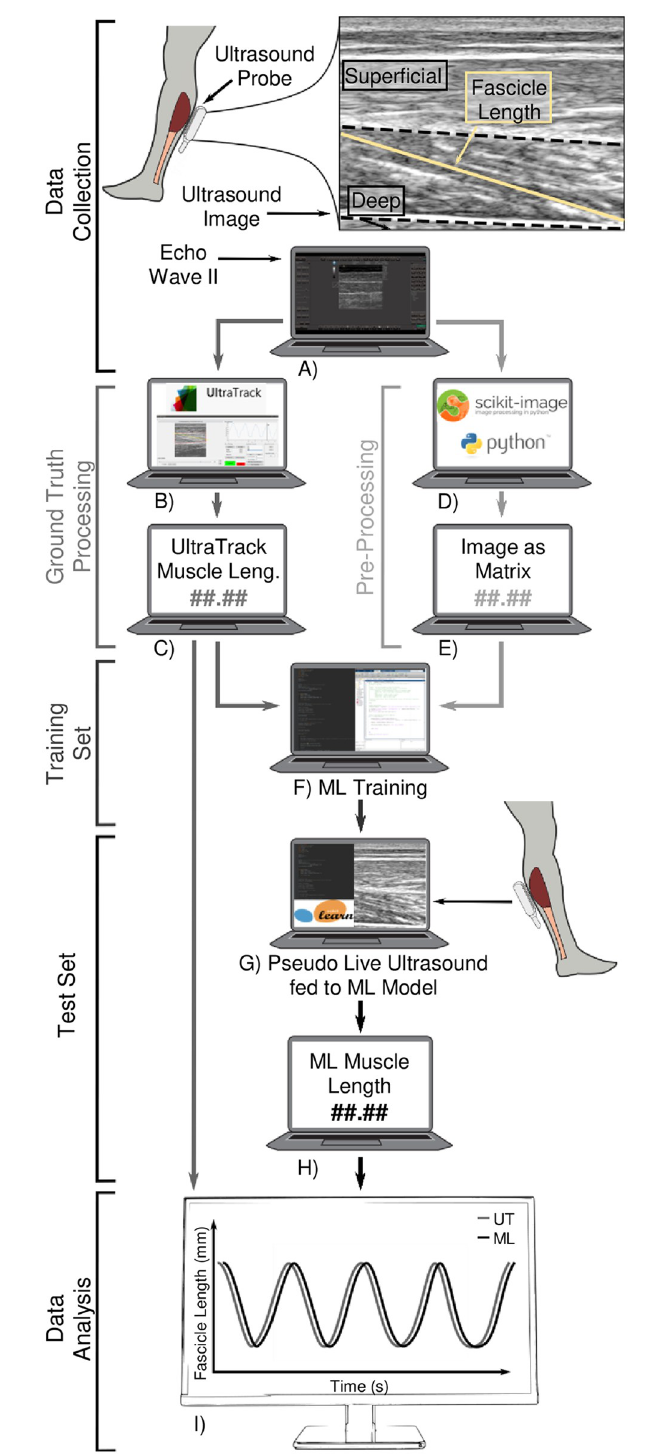
Fig 2. Workflow from B-mode ultrasound image acquisition and processing to machine-learning (ML) model training and real-time muscle length tracking. A) In each frame, a B-mode image containing human soleus muscle fascicle (yellow line) is captured via ultrasound probe. B-C) Training and ground truth muscle fascicle length change data sets are obtained via UltraTrack software. D-E) Images in each frame are cropped and down-sampled using Python code to implement open-source functions. F) A machine learning (ML) model is trained using outputs from C